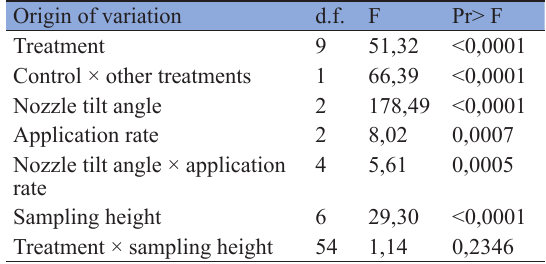
Table 1. Analysis of variance of copper deposit by a mixed model for repeated measurements.